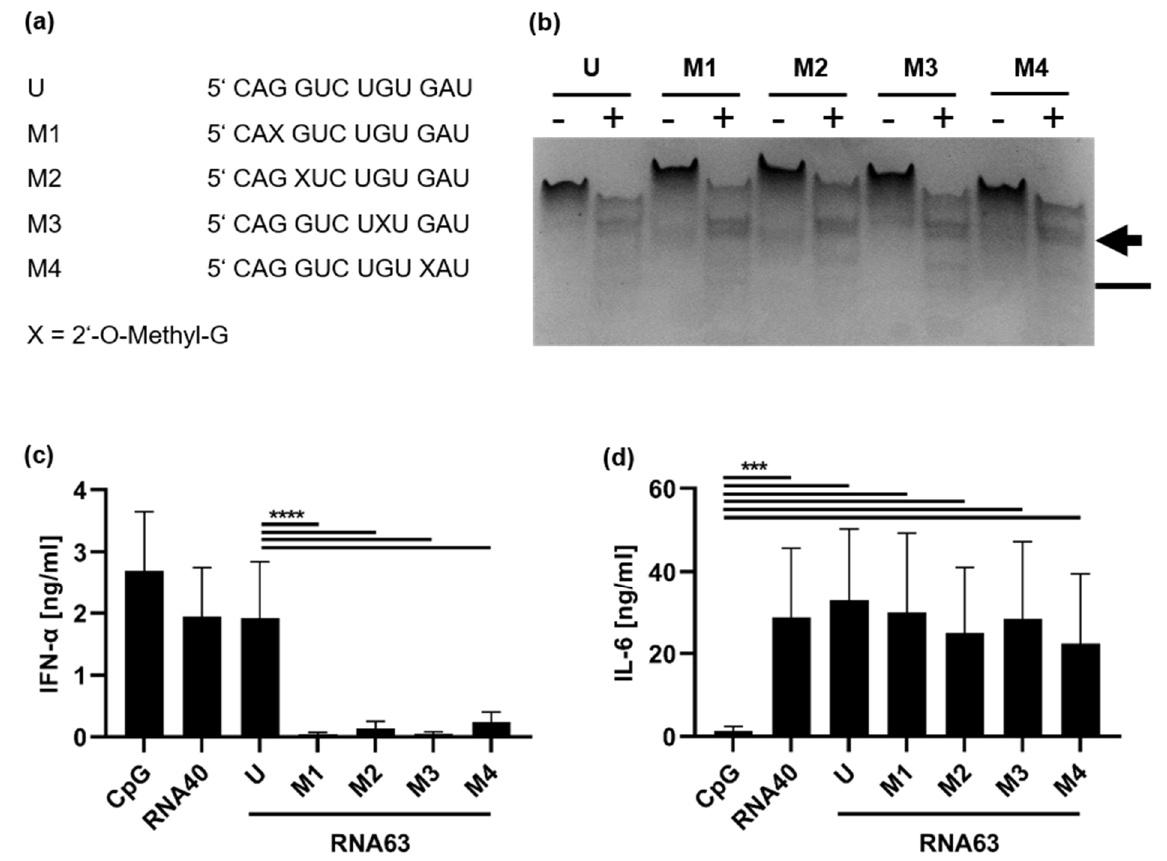
Figure 1. Methylation by 2′-O-ribose prevents IFN-α but not IL-6 secretion, independent of the position. ( a ) Sequences of unmethylated RNA63 (U) or methylated derivatives (M1, M2, M3, and M4): 2′-O-ribose-methylated guanosines are indicated with an X. ( b ) RNA63 derivatives were either treated with 0.005 units of RNase T2/µg RNA (+) or mock treated (−), and RNA fragmentation was visualized in polyacrylamide gel electrophoresis. Position of the RNA fragments of interest are in- dicated with an arrow (